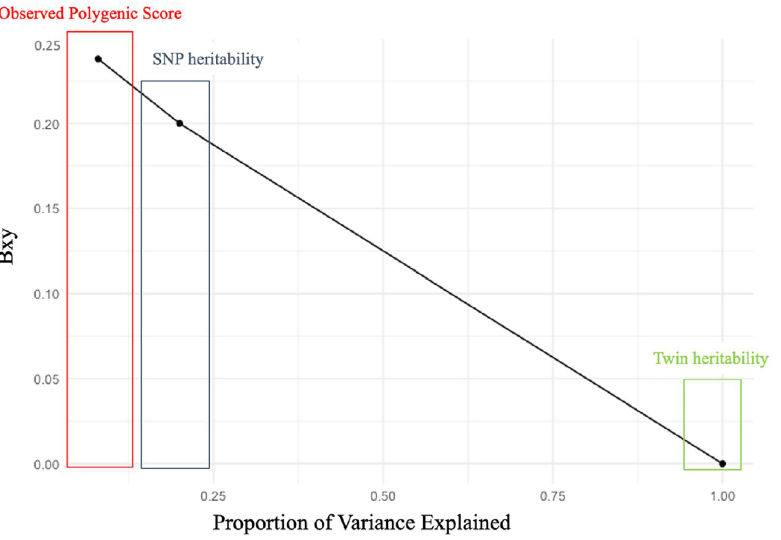
Figure 5. Genetic confounding in the association between online victimization and depressive symptoms when adjusting for observed polygenic scores (red), and under a SNP (blue) and twin (green) heritability scenario. Note : Bxy = standardized estimate of the relationship between online victimisation and depressive symptoms when using observed depression polygenic scores (red), depression polygenic scores that explain SNP heritability in depression (blue) and depression polygenic scores that explain twin heritability in depression